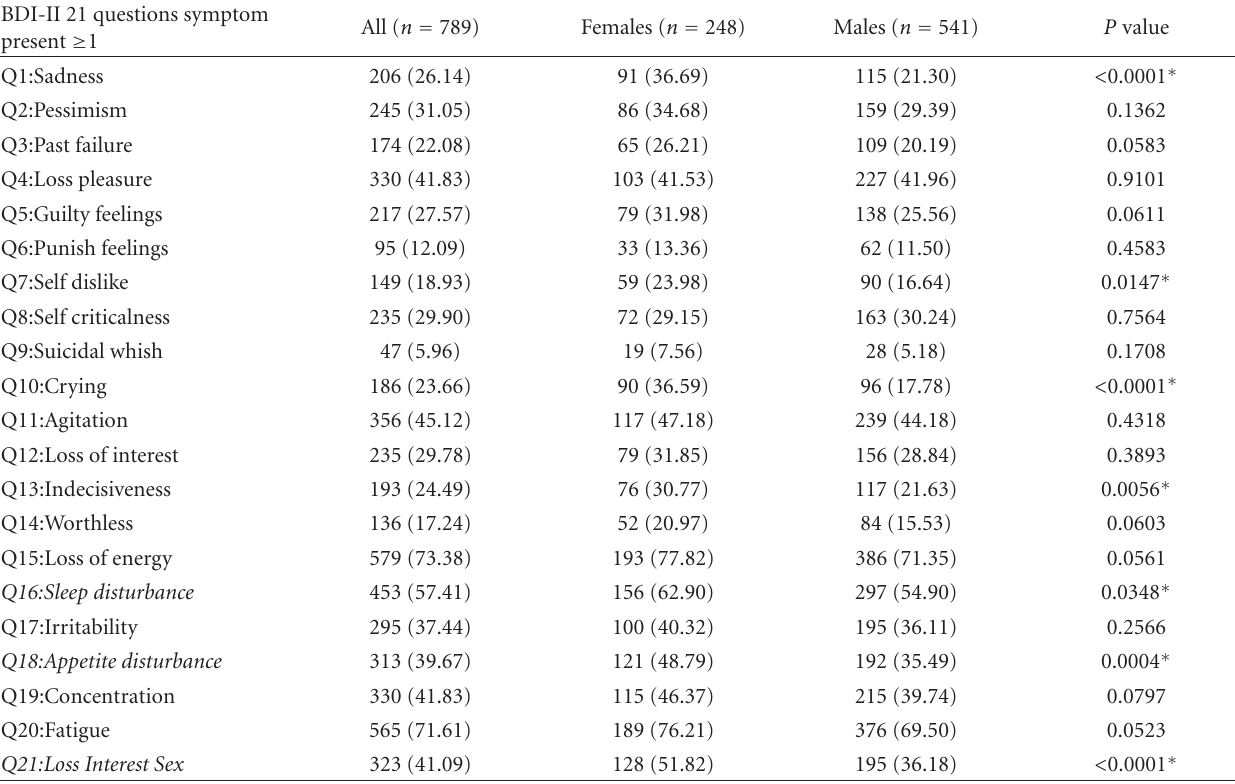
Table 2: Proportional comparison of each individual BDI-II